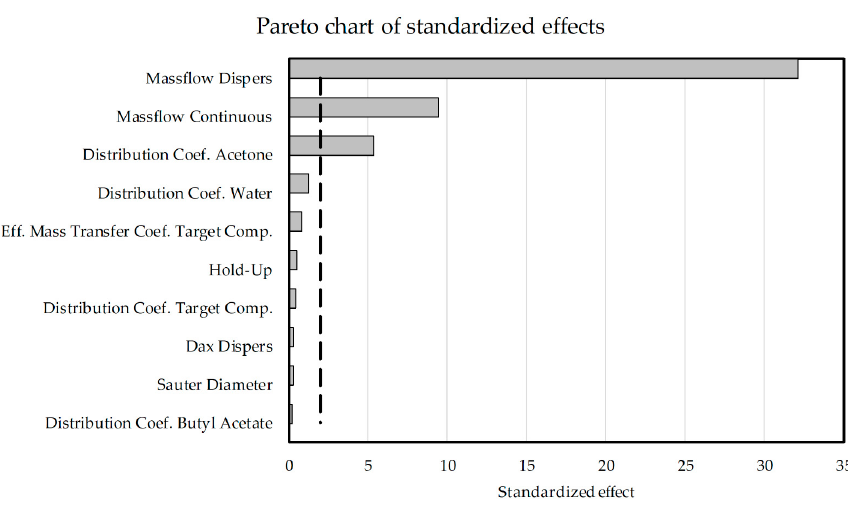
Figure 7. Results of multi-parameter-at-a-time sensitivity study that reveal statistically significant model parameters. Parameters that cross the reference line (dashed) are statistically significant.